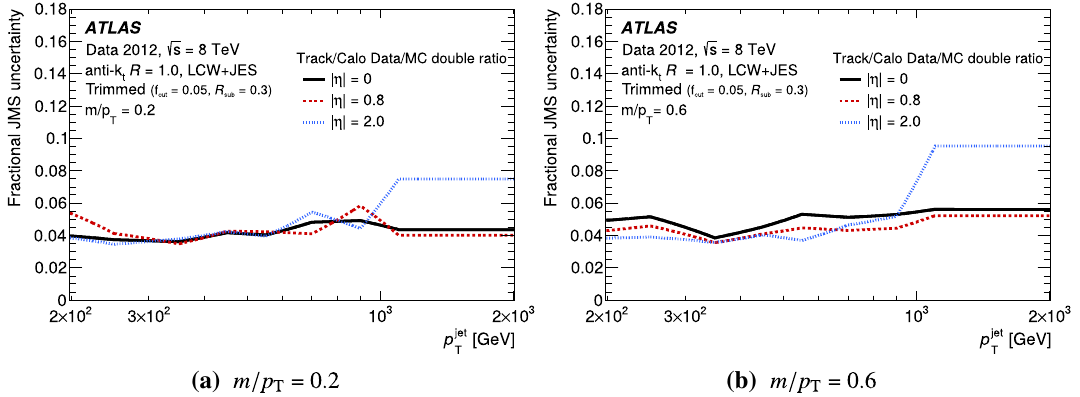
Fig. 46 Jet mass scale (JMS) uncertainties for anti- k t R = 1 . 0 trimmed jets ( f cut = 0 . 05 and R sub = 0 . 3) in different detector regions for a m / p T = 0 . 2 and b m / p T = 0 . 6